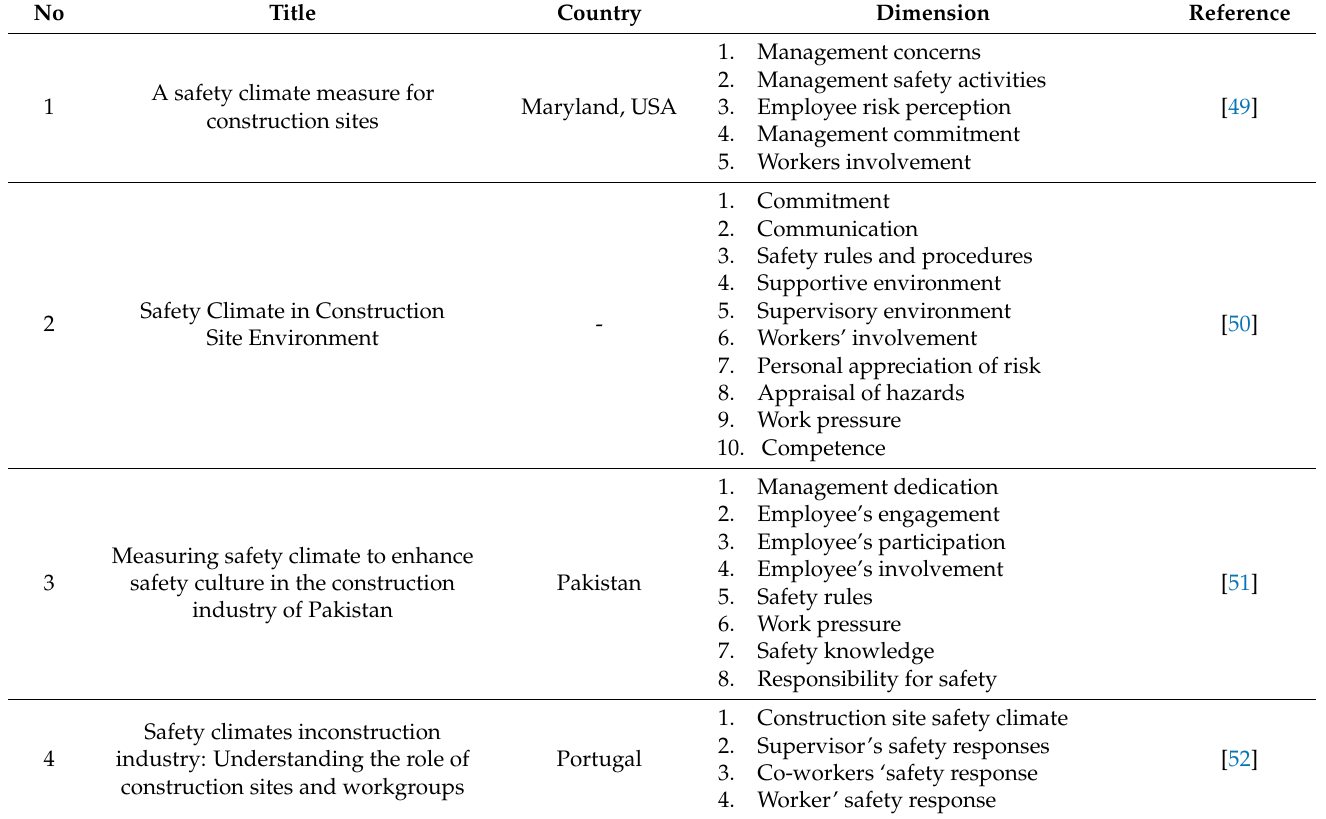
Table 1. The studies of the safety climate in construction sectors. Country